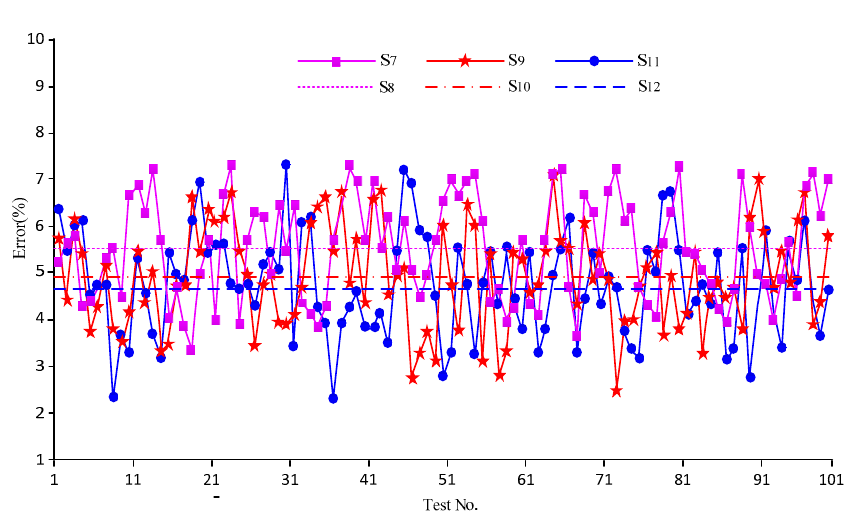
Figure 14. Measurement error curves of the sensor when measuring the bubble flow under different pressures. S 7 : error under the pressure of 0.8 MPa and at 20 °C; S 8 : mean value of S 7 ; S 9 : error under 0.4 MPa and at 20 °C; S 10 : mean value of S 9 ; S 11 : error at 0.1 MPa and at 20 °C; S 12 : mean value of S 11 .